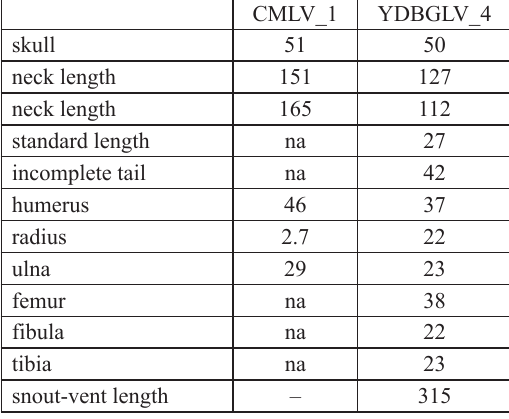
Table 1. Key measurements (in mm) of unidentified pachypleurosaurs from Myanmar (after Sander 1989). Standard length is defined as the length of the four posterior dorsal centra; na, not available (as the specimen is